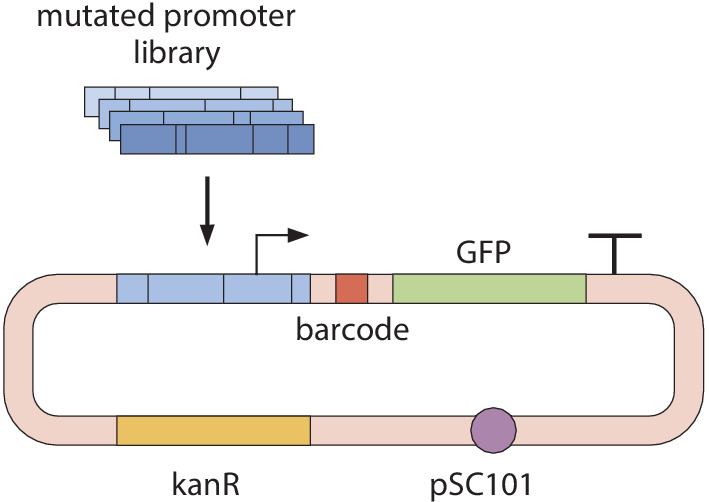
Schematic of the genetic construct used in this study.Mutated DNA libraries for each regulatory region were expressed from a pSC101 plasmid with kanamycin resistance (kanR). Each mutated sequence is 160 bp in length, which includes 45 bp downstream and 115 bp upstream of a given TSS. Each mutated sequence is flanked by primer-binding sites to facilitate cloning. The genetic construct also contains a random barcode, a ribosome-binding site (RBS), a GFP gene, and a terminator labeled with a large 'T'.